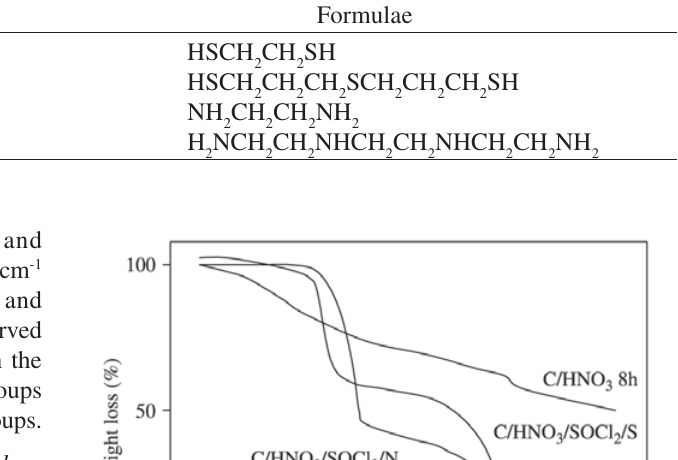
Table 2. S and N molecules grafted on carbon surface. Molecule Formulae